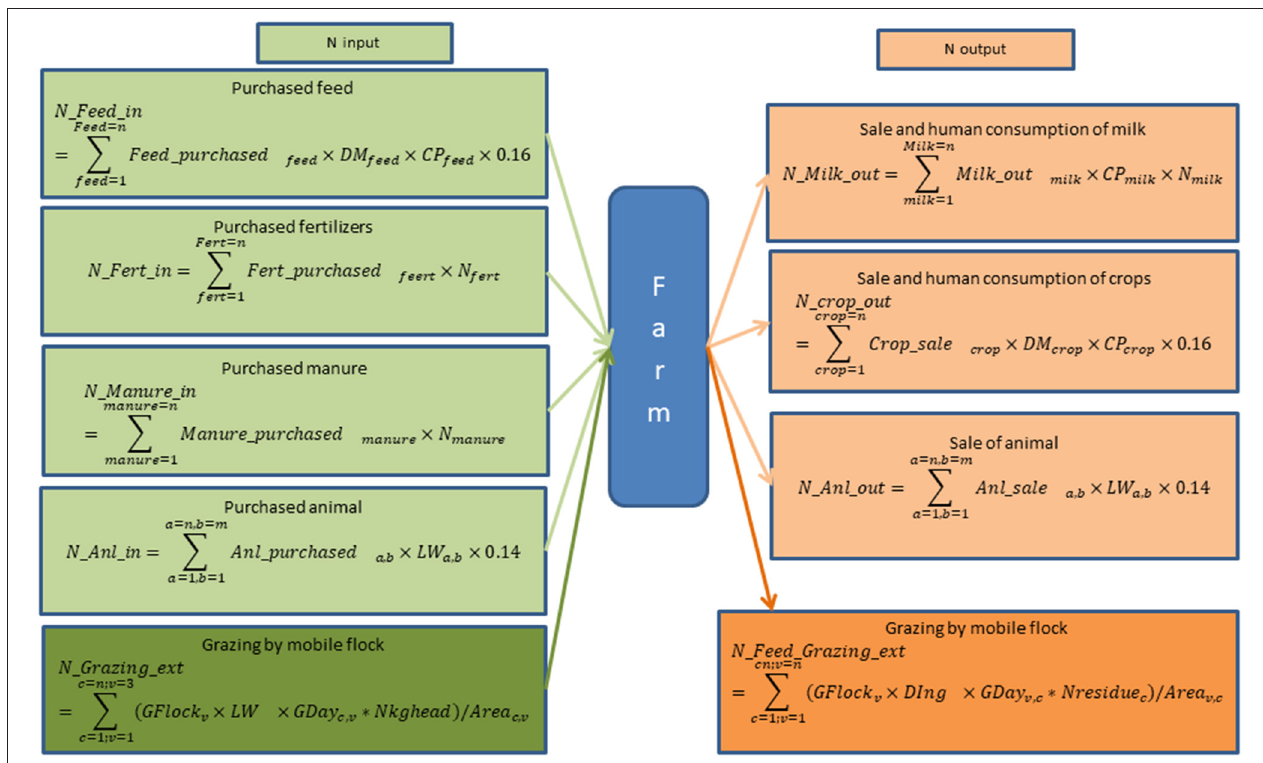
FIGURE 2 | Calculation of Nitrogen farm balance without (light color) and with (light and dark colors) taking account N flows due to grazing of mobile flocks. Feed: category of feed; Feed_purchased: quantity of feed purchased (kg yr I); DM: Dry matter intake; CP: crude protein content per kg; Fert: category of mineral fertilizer; Fert_purchased: quantity of purchased fertilizer per year; N: nitrogen content per kg; manure: type of manure (origin; mode of spreading); manure purchased: quantity of manure purchased per type; a: category of ruminant (buffalo; cattle; sheep; goat); b: category of age; An l_purchased: number of animal purchased; LW: live weight per head; Milk: category of milk product (by specie; by product: fresh, butter cheese); Milk_out: quantity of milk use; Crop_out: quantity of crop sold or consumed; crop: type of crop; Anl sale: number of head of animal sold; v: village for territorial nitrogen balance; c: residues crops; GFlock: grazing flock (in number);